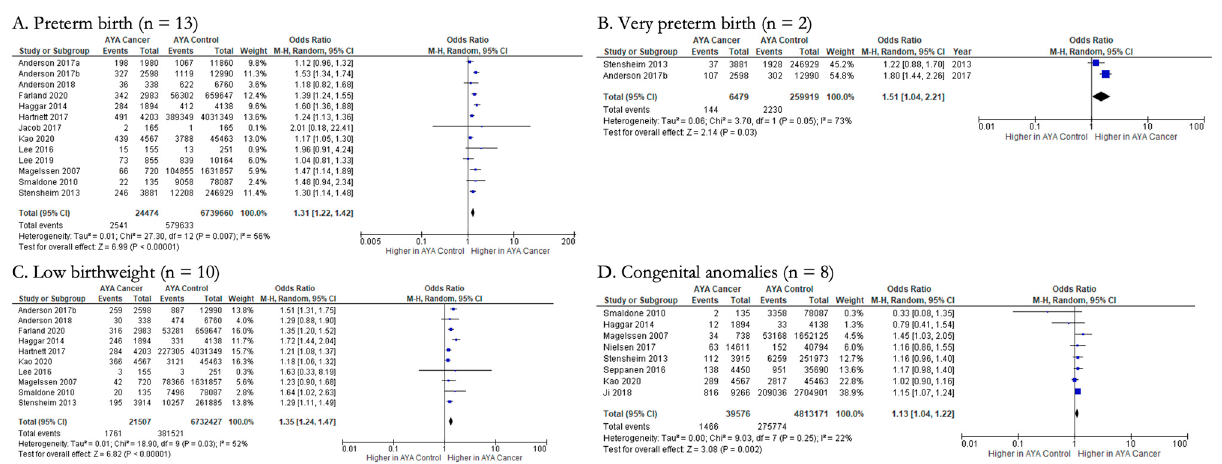
Figure 3. Forest plots for significant fetal/neonatal outcomes reported by two or more studies (n = 4). ( A ). [27–29,31,34–36,39,40,42–45], ( B ). [31,42], ( C ). [27–29,31,36,39,40,42,44,45], ( D ). [27,29,31– 33,36,37,40].